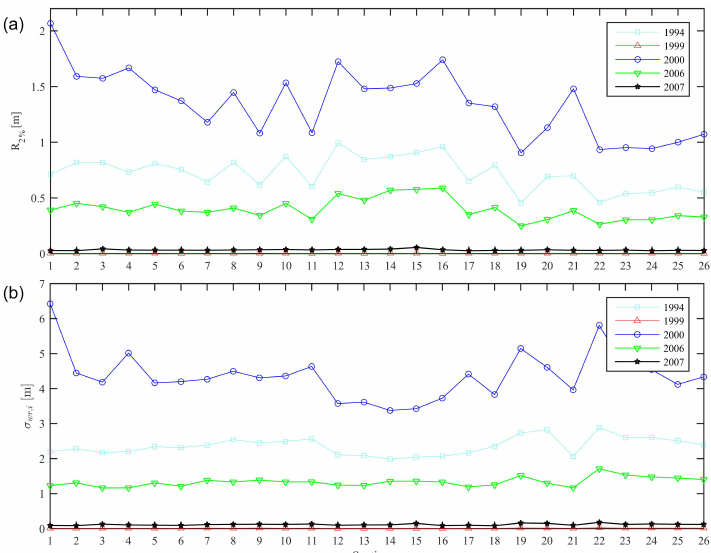
Figure 5. (a) R 2% of the wave run-up output of the Boussinesq model; (b) standard deviation of the shoreline movement due to wave